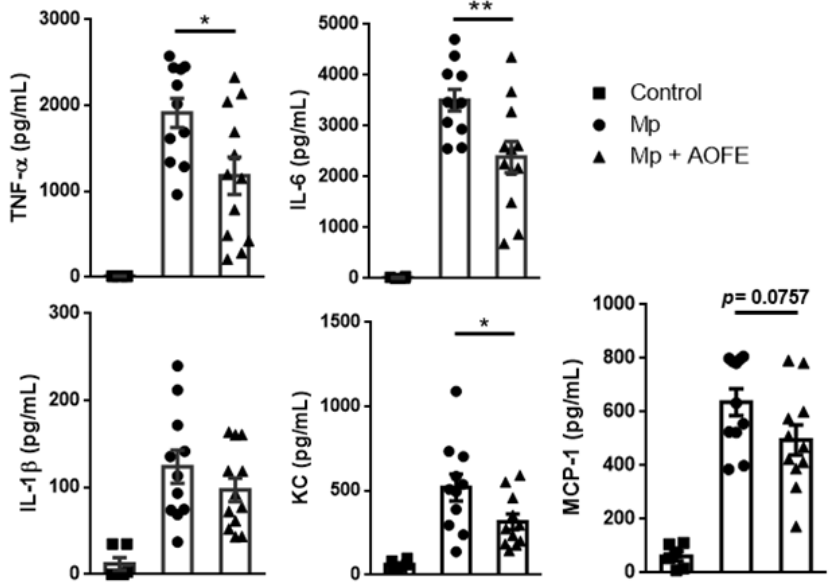
Figure 7. AOFE administration reduces proinflammatory cytokine production in Mp-challenged mice. BALB/c mice were treated as described in Figure 6. At 24 h post Mp inoculation, TNF- α , IL-6, IL-1 β , KC, and MCP-1 levels in BALF were analyzed by ELISA. The data shown are combined from 3 independent experiments. * p < 0.05, ** p < 0.01.